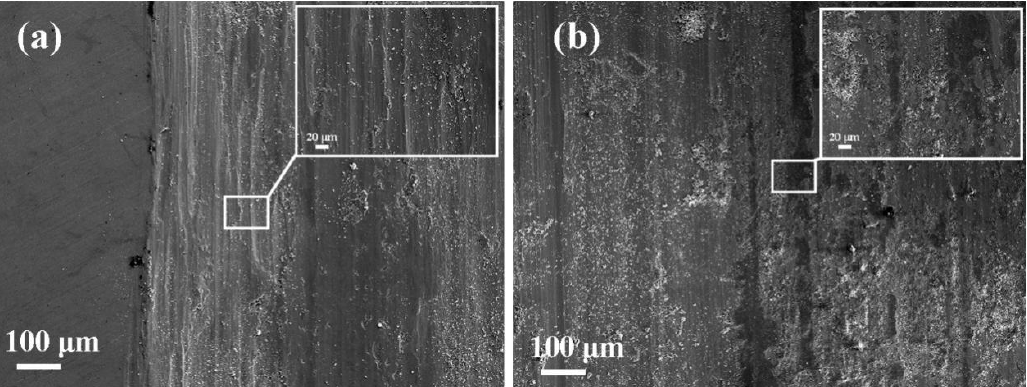
Figure 12. SEM images of worn surfaces of Inconel625 alloys coatings after friction and wear tests: ( a ) under UHSLC; ( b ) under LSLC.